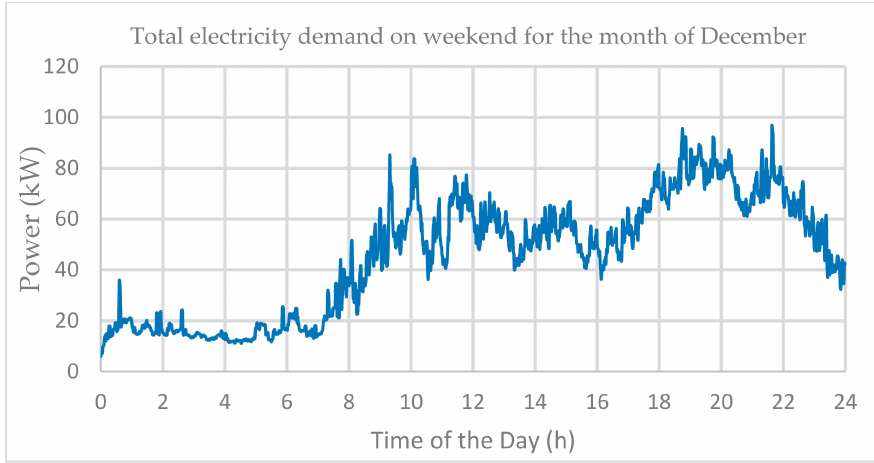
Figure 9. Load profile 3 for the month of December over 24